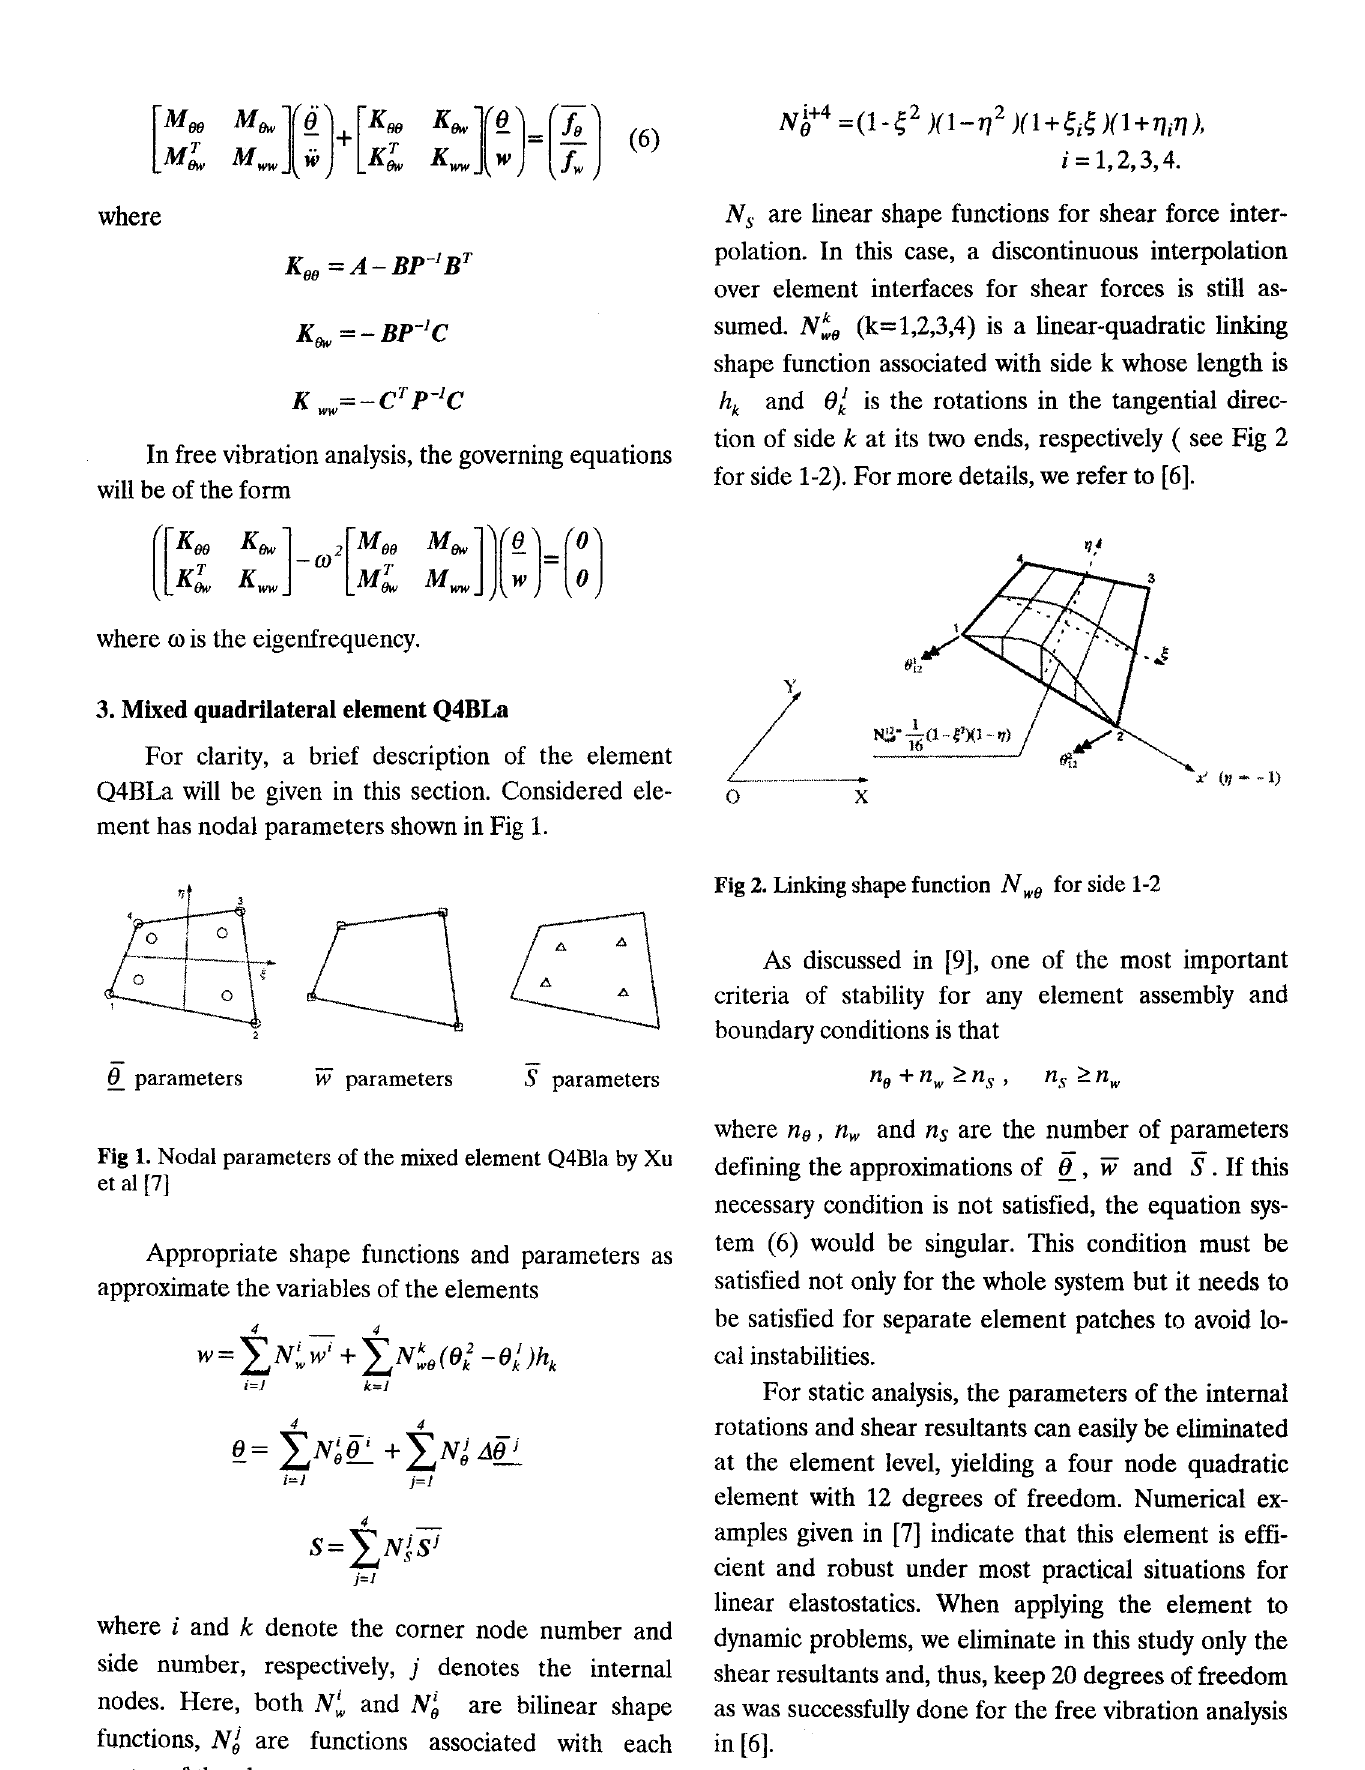
Fig 1. Nodal parameters of the mixed element Q4Bla by Xu